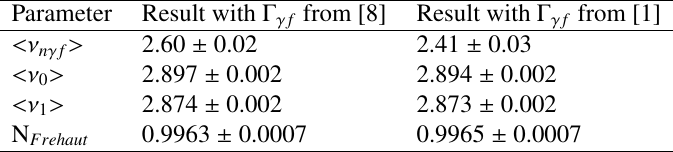
Table 2. Output parameters obtained from the fit to the ν p experimental data. Parameter